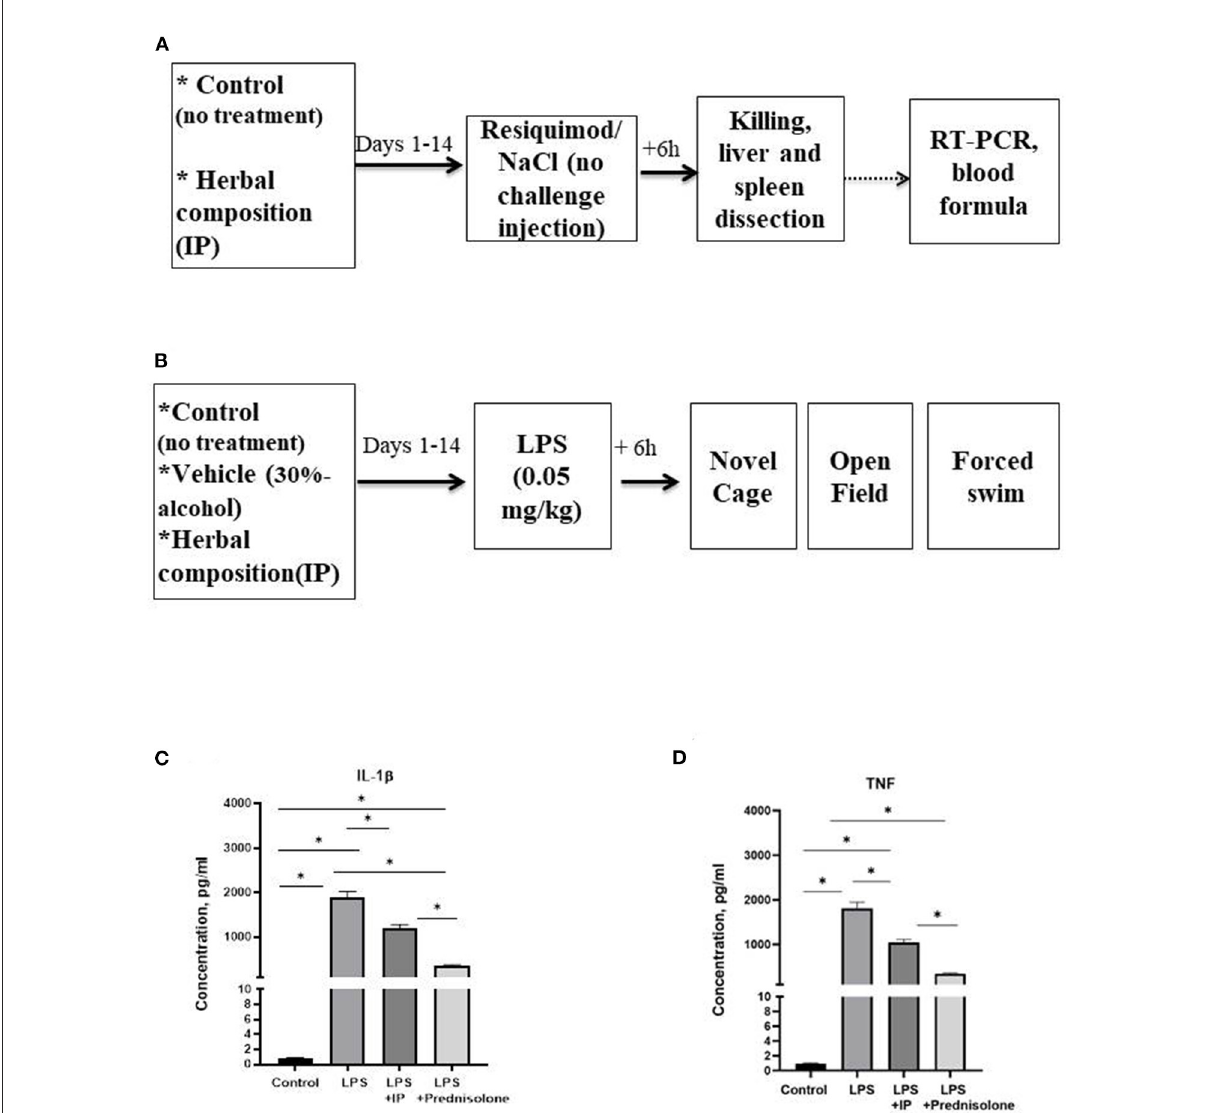
FIGURE1 Schematic of in vivo tests performed and the outcome from the in vitro assay. In the in vivo experiments, animals were exposed to a daily administration of herbal drops or vehicle during the 14 days. On the day of the experiment, mice received an intraperitoneal injection (A) with resiquimod or vehicle and killed 6h post-challenge, (B) with LPS or vehicle and 6h post-challenge completed the novel cage, open field, and the forced swim test. In the in vitro assay, herbal drops or prednisolone was applied in the human macrophage cell culture that was treated with LPS. In comparison with the non-stimulated samples, there was a significant increase in the concentrations of (C) IL-1 β and (D) TNF in all LPS-challenged samples. Significant group differences: *vs. non-challenged samples, (one-way ANOVA and Tukey’s test). Data presented as mean ±